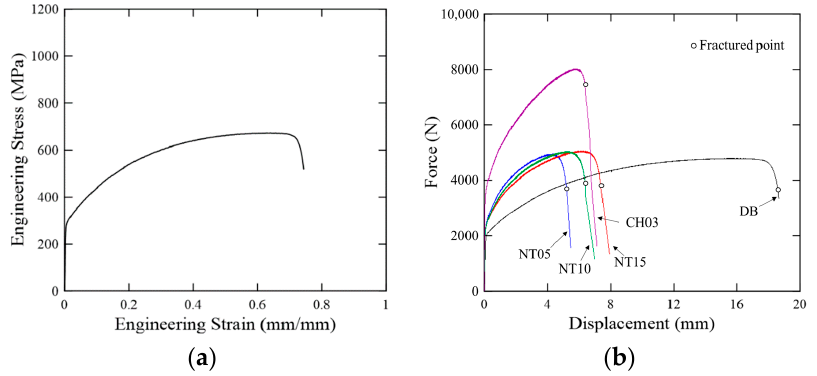
Figure 3. ( a ) Engineering stress–strain relationship at room temperature for DB specimen and ( b ) force–displacement relation. Given that the DB and NT specimens have the same minimum width, the maximum strength is almost the same. The smaller notch radius of the NT specimen caused increased stress triaxiality and rapid failure. In order to observe the failure pattern of each specimen, the picture just before failure in the material test is shown in Figure 4. In the NT specimen, localized necking was ob- served in the center of the specimen, after which fracture progression was observed in the outer direction of the specimen. The CH03 specimen also begins to crack on both sides of the center hole and propagates outward. The fracture angle of all STS304L specimens was observed irregularly and it was judged that there was no tendency. As the purpose of the material test is to establish the ductile fracture criteria, no examination of the fracture sur- face of the specimen was conducted, nor was the effect of the notch radius on the material behavior analyzed through experimental results. ( a ) ( b )